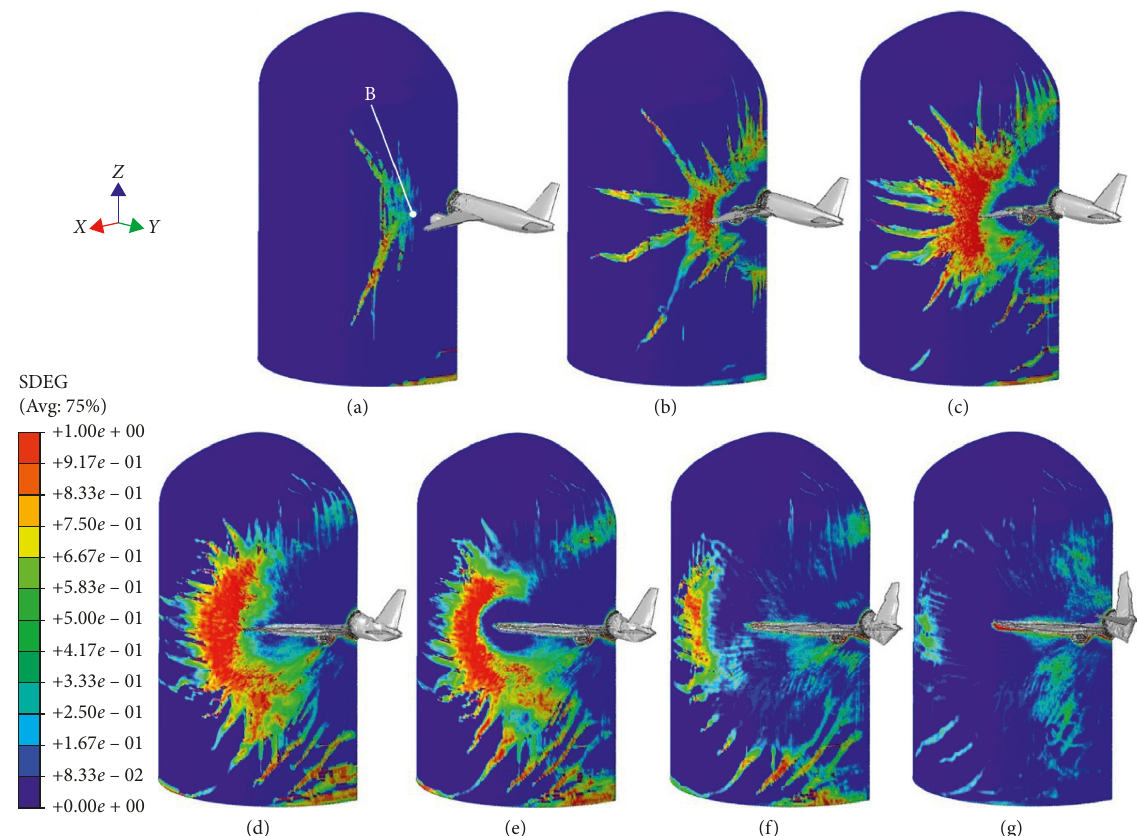
Figure 13: Snapshot from analysis of Boeing 767-200ER crash on the containment (wing tank case). (a) 0.10s. (b) 0.15 s. (c) 0.20 s. (d) 0.25s. (e) 0.27s. (f) 0.30s. (g)